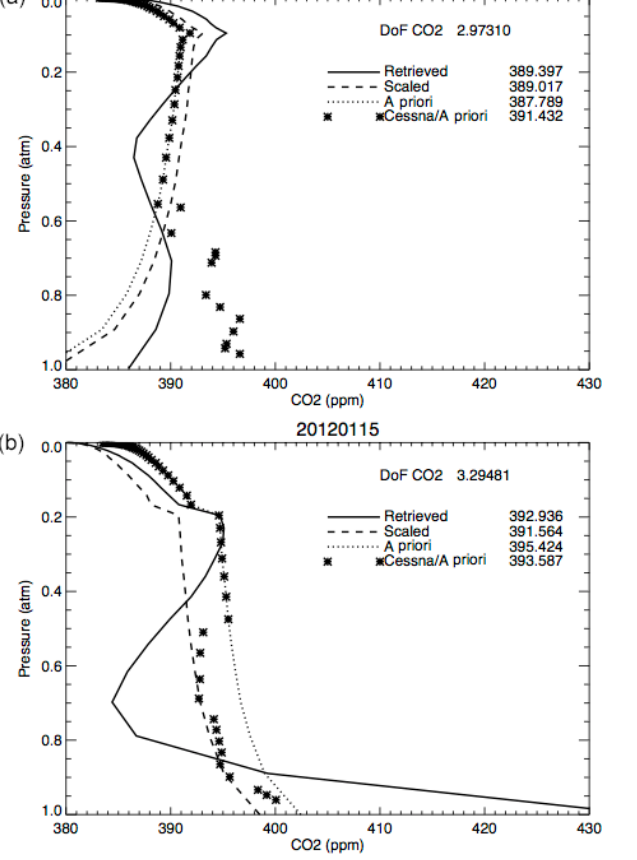
Figure 11. (a) Average retrieval within about 1h of a Cessna over- flight, assuming variable SNR, on 28 July 2011. (b) As (a) but for 15 January